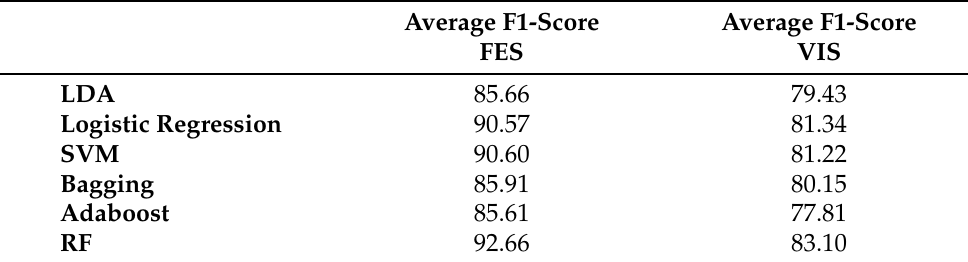
Table 5. Combining optimal transport with other existing